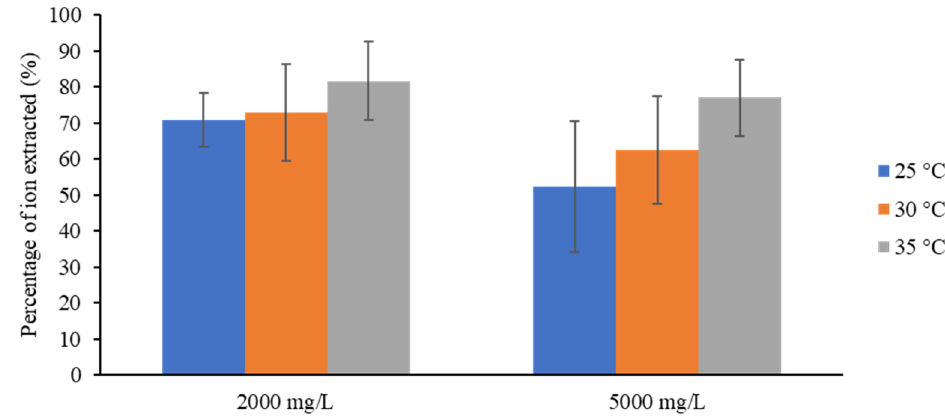
Figure 6. Effect of the inlet temperature on removal efficiency in experiments at 10 V.